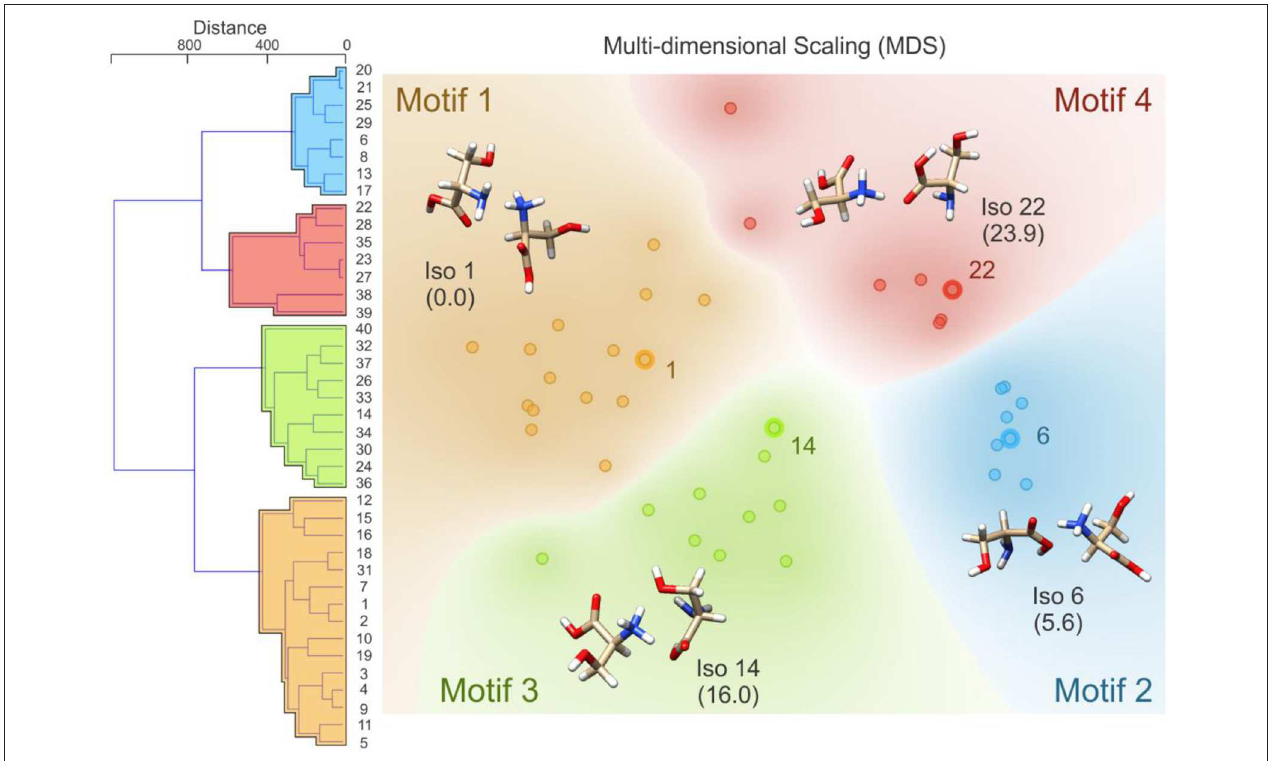
FIGURE 4 | (Left) The distance dendrogram for the protonated serine dimer. Isomer numbers are indicated for each branch of the dendrogram. (Right) A multi-dimensional scaling 2D projection of the hierarchical clustered data. Isomers are numbered in order of increasing energy above the global minimum (isomer 1). Standard Gibbs energies (in parentheses) are reported in kJ mol − 1 . Calculations were conducted at the B3LYP/6-311 implemented in Gaussian 09 (Frisch et al.,